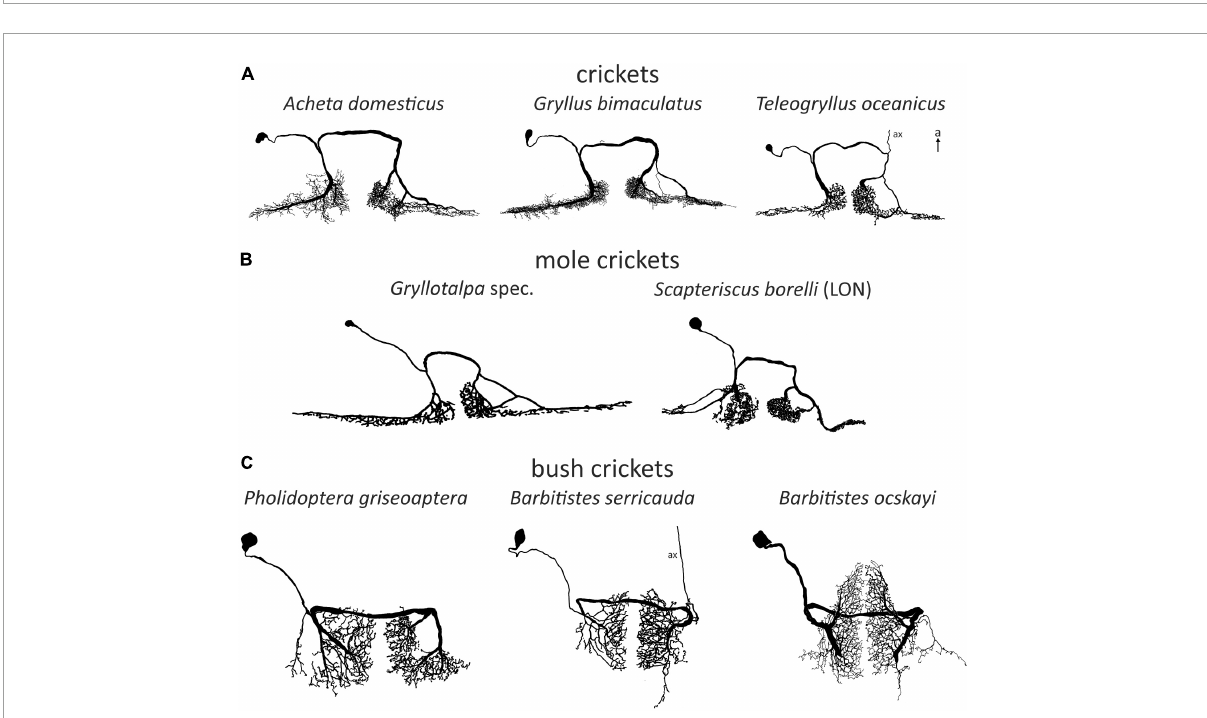
FIGURE2 Examples of omega (1) neurons in Ensifera. Soma-ipsilateral branches have a fine dendritic structure, soma-contralateral branches have a more beaded appearance typical for axonic arborizations. (A) Field crickets. T. oceanicus modified with permission after Atkins and Pollack (1986). (B) Mole crickets. In Scapteriscus there are two ON1-like morphologies, one is interpreted as more ON1-like (“high-frequency-tuned omega neuron”). Gryllotalpa modified after Zhantiev and Korsunovskaya (1990a); Scapteriscus modified with permission after Mason et al. (1998). (C) Bush crickets. Neurons not drawn to scale for better comparability. a, anterior; ax,